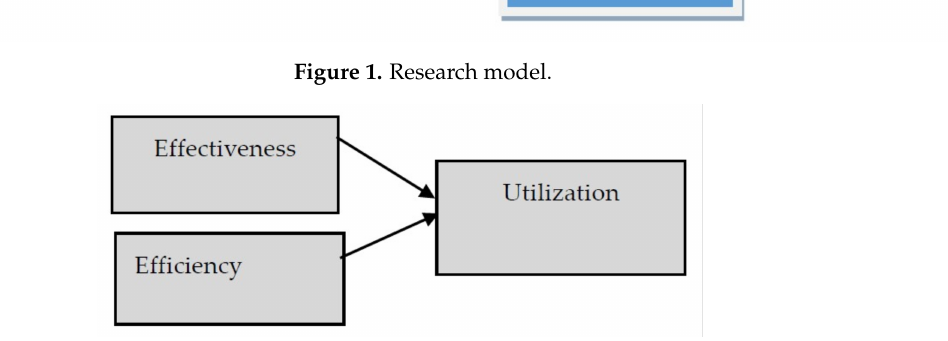
Figure 2. Technology Utilization Theory